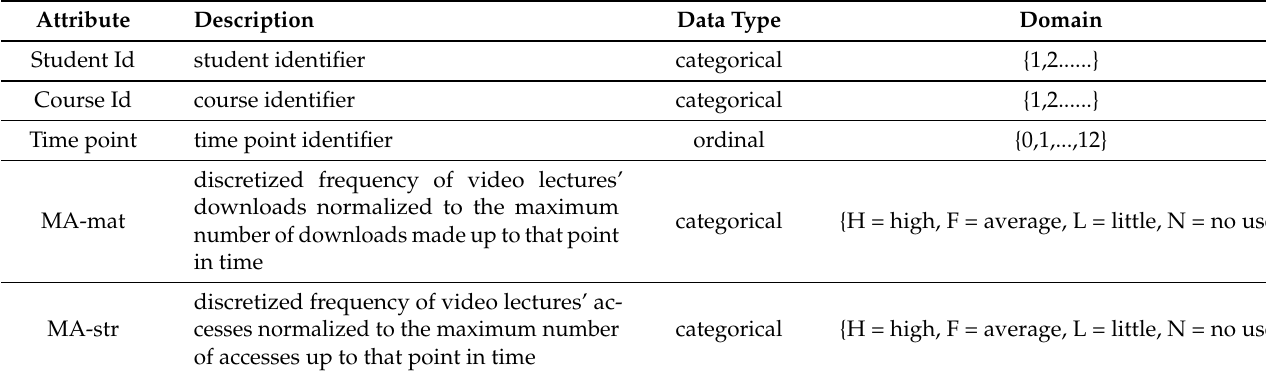
Table 4. Schema of the Courses-Activities table.